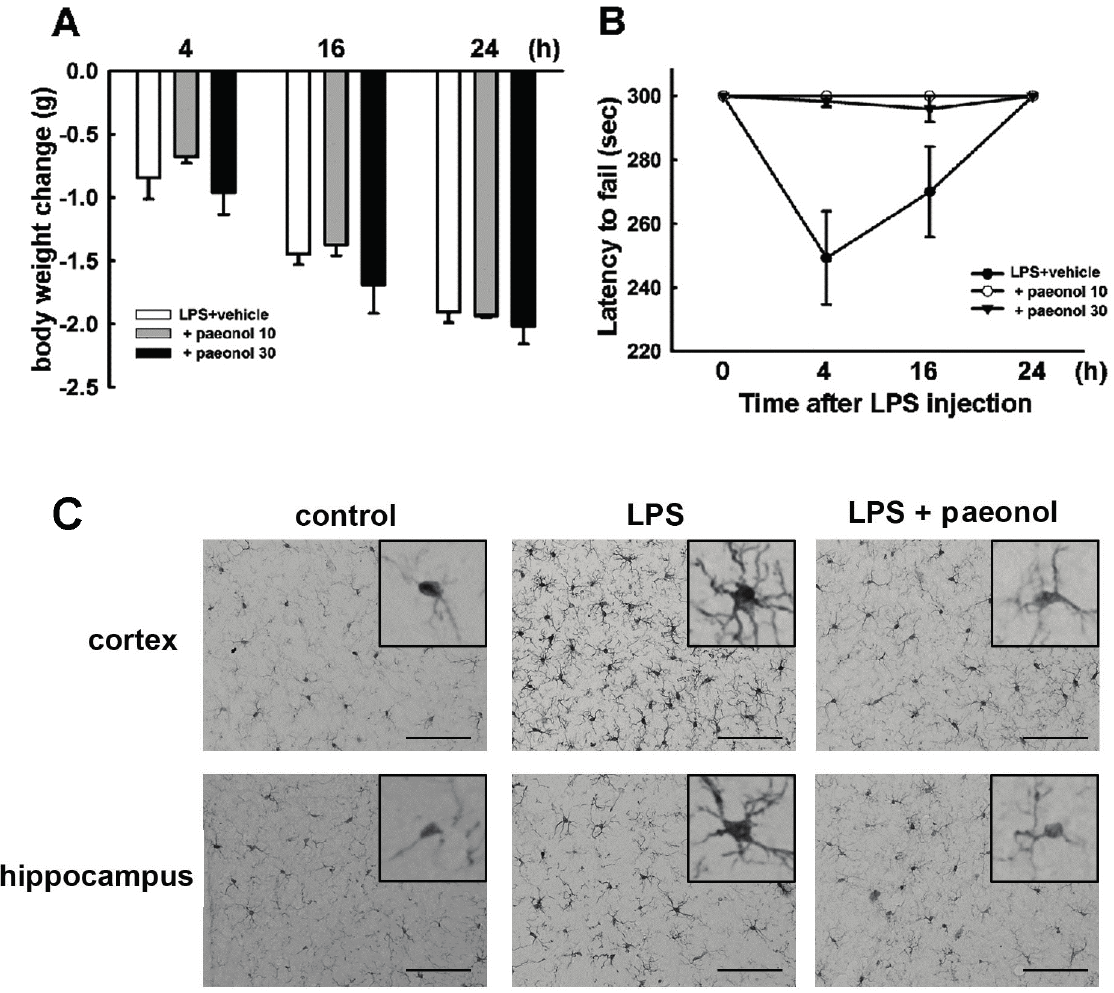
Figure 5. Effects of paeonol on LPS-induced motor coordination dysfunction and microglial activation. Mice were treated with paeonol and a single intraperitoneal injection of